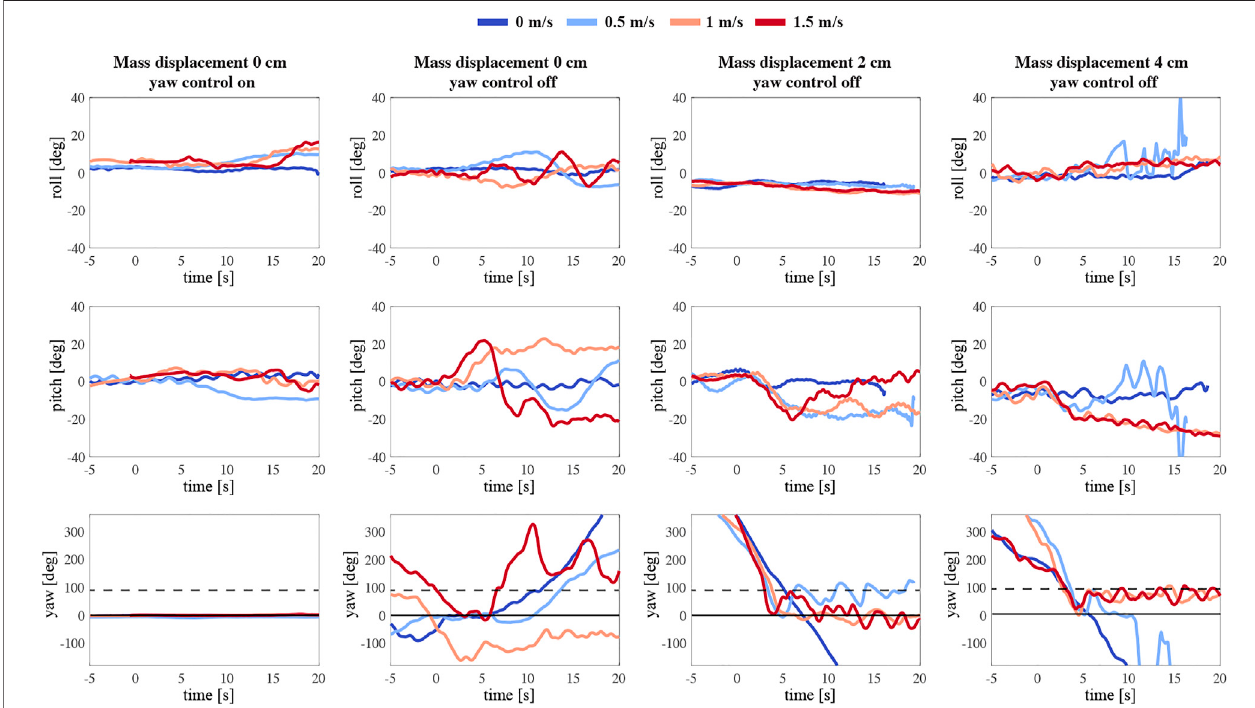
FIGURE12| Thetemporaldynamicsofbodyattitude oftherobotic fl yer fl ying atvarious wind speeds(seelegend ontop),andwithvarious con fi gurations.Thetop to bottom rows show body roll, pitch and yaw data, respectively. The fi rst to last column show results for the various con fi gurations, which are a mass displacement of 0 cm and yaw control on and off ( fi rst and second row, respectively), and yaw control off with a 2 and 4 cm mass displacement (third and last column, respectively). The solidhorizontalblacklineat0 ° yawanglecorrespondstosidewayspositionoftherobotwithrespecttotheincomingwindgust,andtheblackdashedlineat90 ° yaw angle corresponds to forward fl ight into the incoming wind